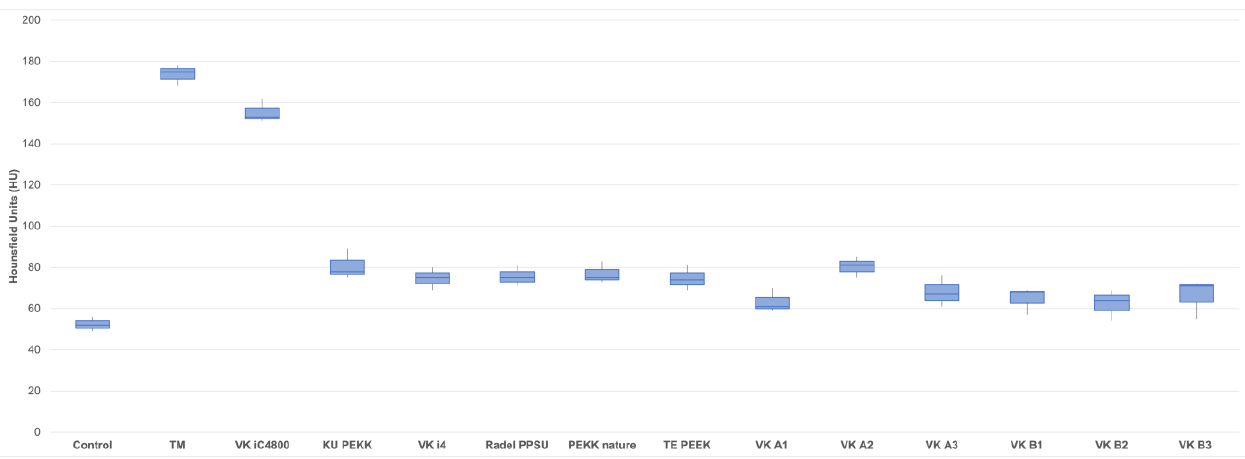
Figure 7. Boxplots of mean Hounsfield Unit (HU) values for all 12 polymer implants (VK iC4800; KU PEKK; VK i4; Radel PPSU; PEKK nature; TE PEEK; VK A1; VK A2; VK A3; VK B1; VK B2; VK B3), TM and control. Mean values are provided in Table 2.